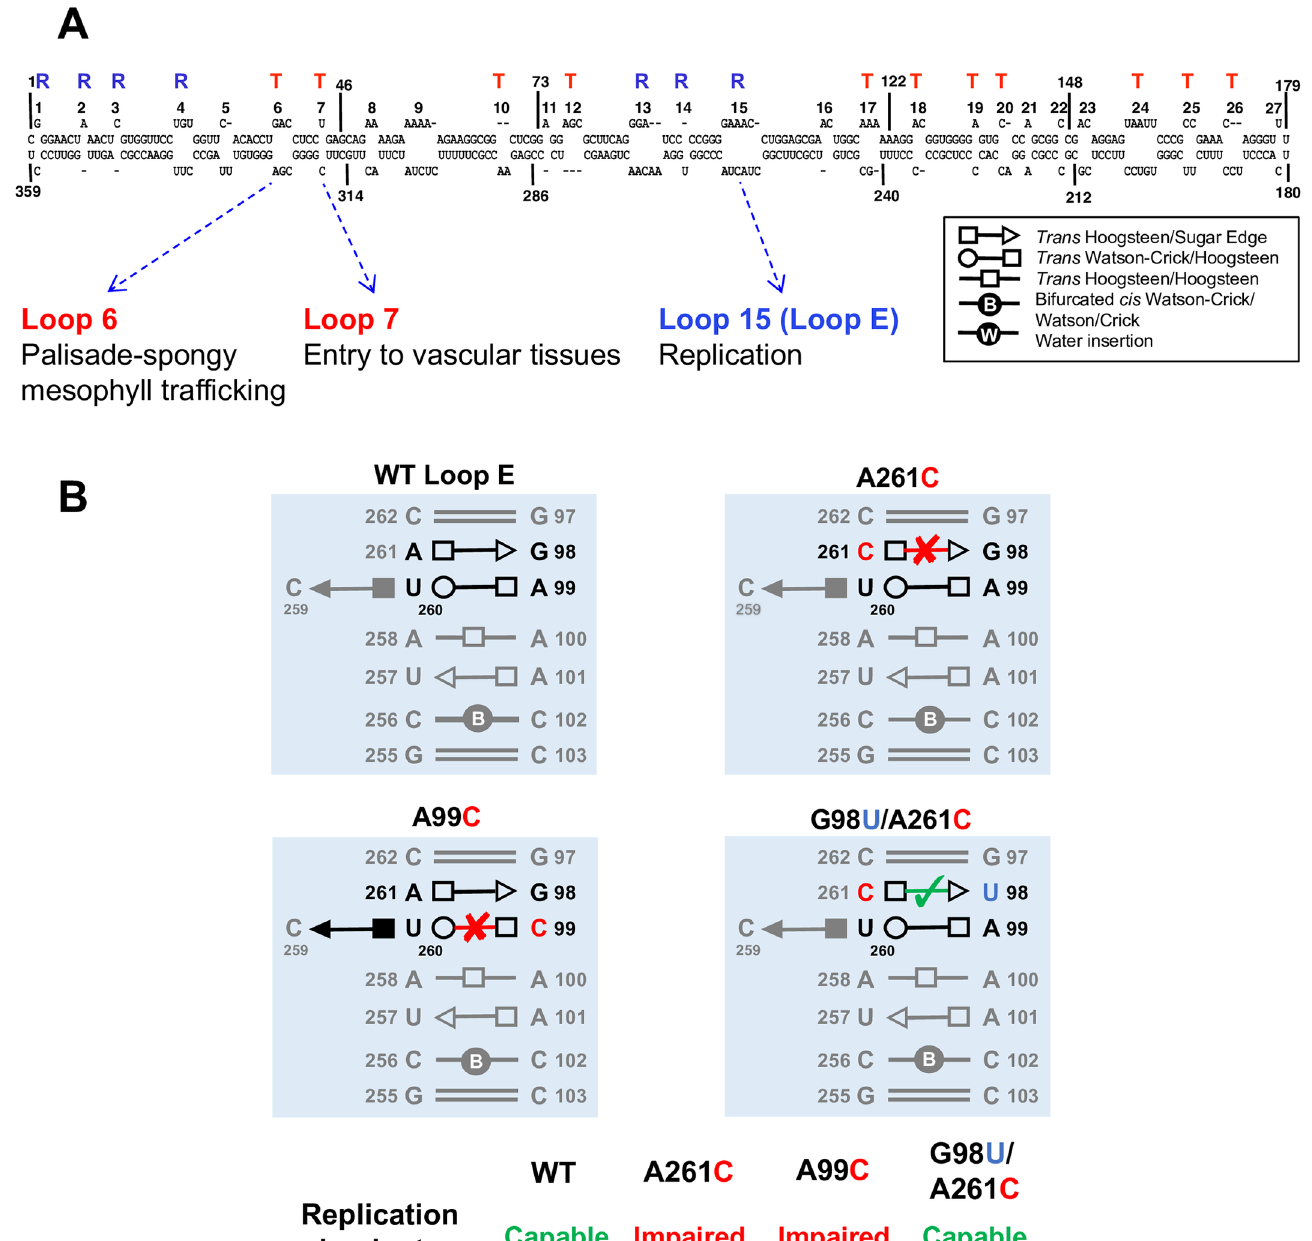
Fig 2. PSTVd RNA structures. (A) The 2D organization of PSTVd RNA genome. 3D structural arrangements and the function of loop 6, loop 7, and loop E are listed [17–19].“T” and “R” depict the functions in “trafficking” and “replication,” respectively [16]. (B) Disruptive and compensatory PSTVd loop E mutants predicted by isostericity [17]. Illustration for the replication of PSTVd variants in tomato plants, verified by northern blots [17], is shown in the lower panel. PSTVd, potato spindle tuber viroid; WT,